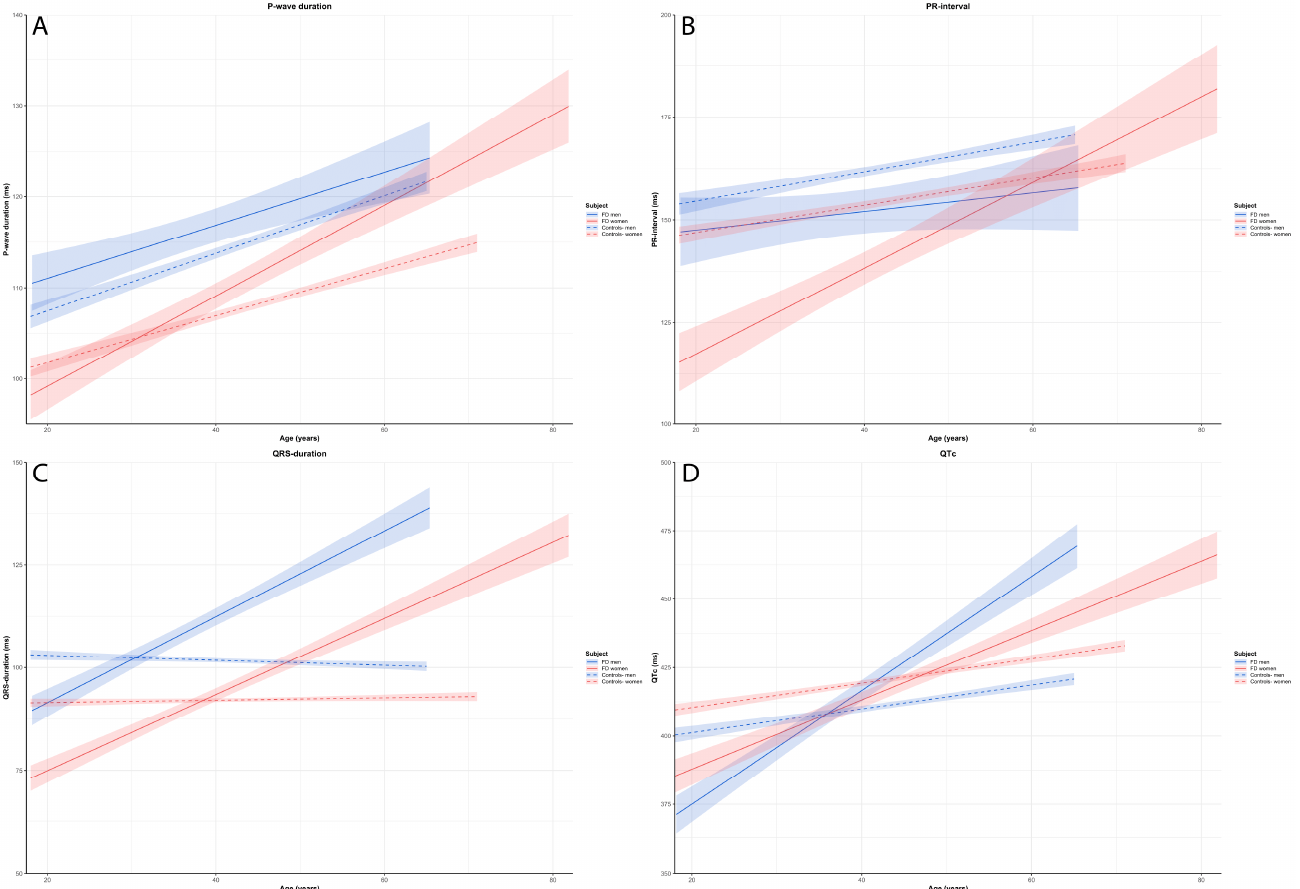
Figure 1. Based on the GLM, the estimated effect plots with the 95%-CI of ( A ) P-wave duration, ( B ) PR-interval, ( C ) QRS-duration and ( D ) QTc for each study participants.